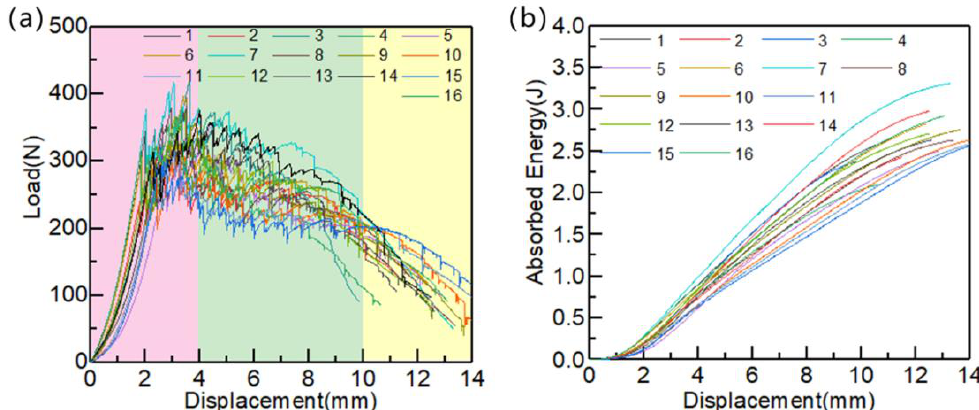
Figure 9. The QSI test results of CF/PA 6 composite laminates formed under different process parameters: ( a ) load–displacement curve; ( b ) energy absorption curve.